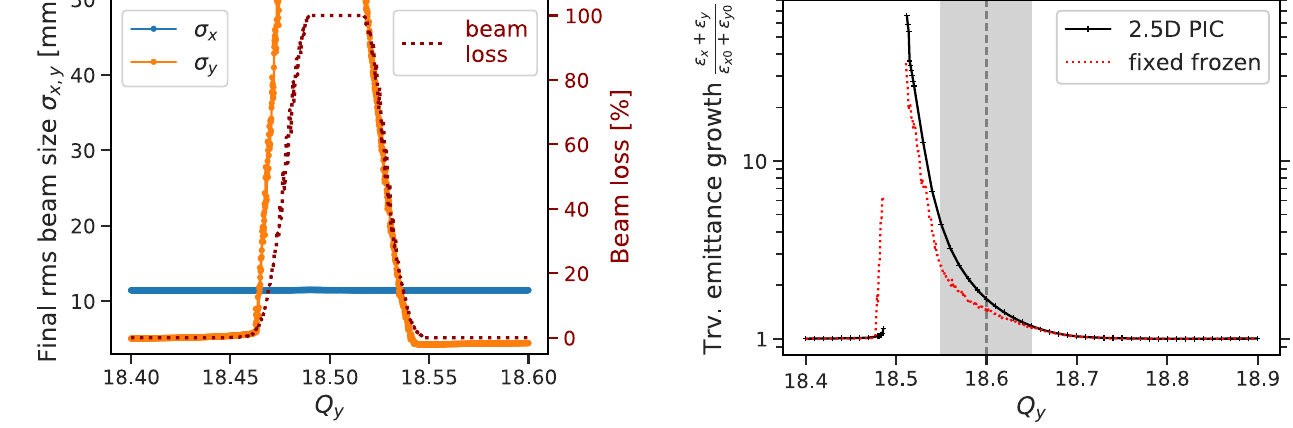
FIG. 5. Comparison between PIC and FFSC space charge models. Transverse emittance growth ratio vs vertical tunes around the quadrupole resonance at fixed Q x ¼ 18 . 75 . The resonance condition for the bunch center Eq. (8) is indicated by the dashed gray line; the gray area around it indicates the zero- intensity stop-band